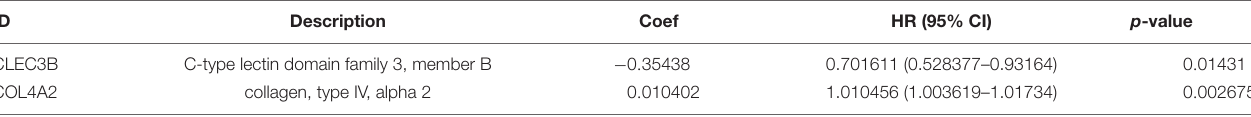
TABLE 3 | Multivariate Cox regression analysis of TMB prognostic model for CCC patients.